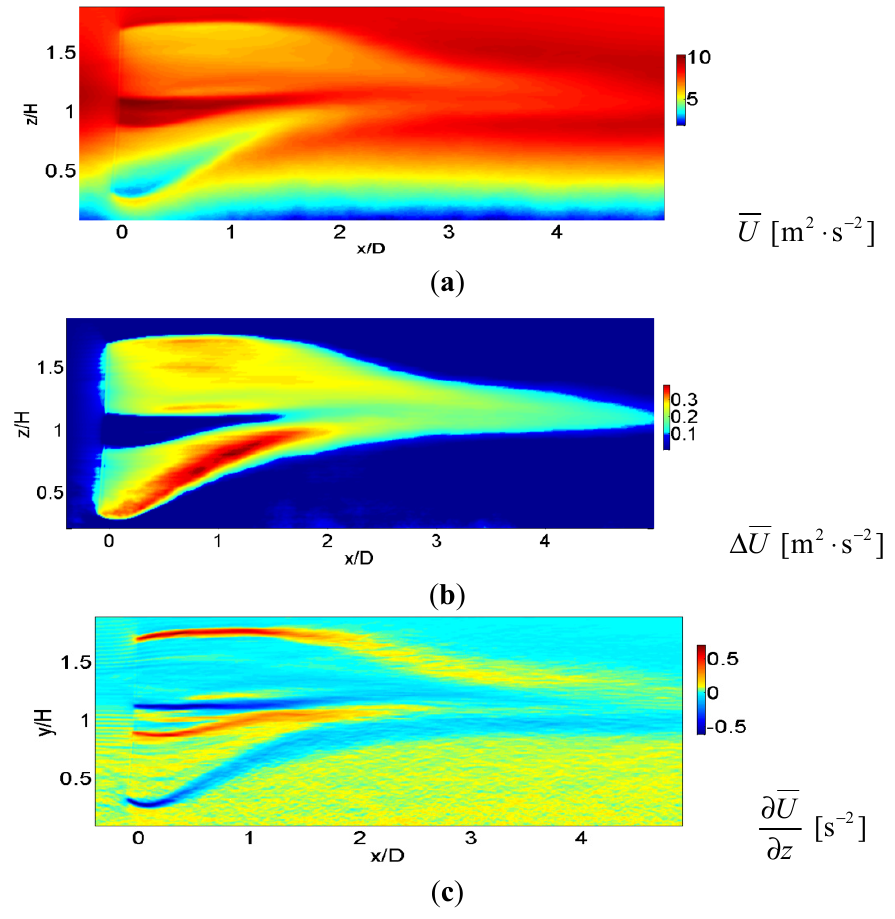
Figure 8. Time-averaged contours of ( a ) streamwise velocity; ( b ) streamwise velocity deficit; ( c ) wind shear ( )/ dzUd , in the x-z plane for WT in moderate-stable ABL